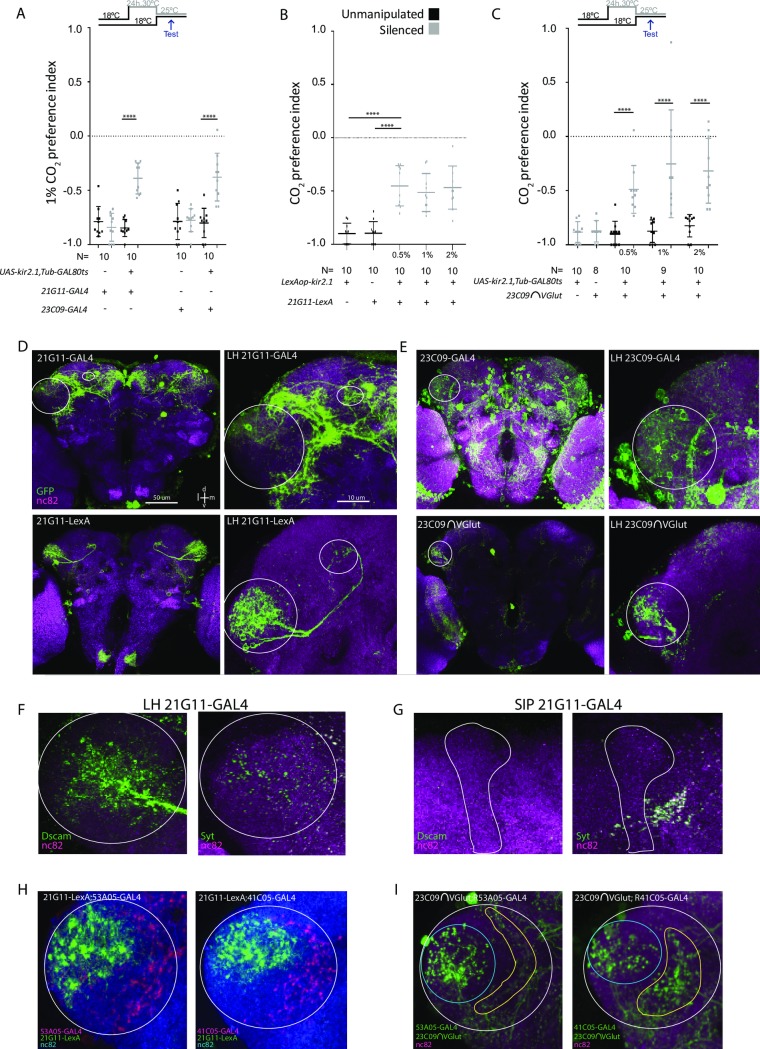
Activity in 21G11 and 23C09 neurons is required for behavioral response to CO2.(A) T-maze response to 1% CO2 of 21G11-GAL4 and 23C09-GAL4 flies driving UAS-Kir2.1, TubGAL80TS expression. (A and C) Black dots, no heat induction of Kir2.1 expression (see Materials and Methods). Gray dots, heat induction of Kir2.1 expression before test. The top and bottom lines represent the first and the third quartiles. The line across the box is the median. (B and C) T-maze response to three CO2 concentrations—0.5%, 1%, and 2%—of the flies with 21G11-LexA driving LexAopKir2.1 expression (B) and 23C09∩VGlut driving UAS-Kir2.1,TubGAL80TS expression (C). For 21G11-LexA driving LexAopkir2.1 expression, black dots represent parental controls, and gray dots represent constitutive Kir2.1 expression. For 23C09∩VGlut driving UAS-Kir2.1, TubGAL80TS expression, black dots represent no heat induction of Kir2.1 expression, and gray dots represent both parental controls and heat induction of Kir2.1 expression before test. Post hoc two-way ANOVA showed no significance when comparing among expressions for both control and test samples. (D) Brain and LH UAS-mCD8-GFP expression of 21G11-GAL4 and 21G11-LexA. (E) Brain and LH UAS-mCD8-GFP expression of 23C09-GAL4 and 23C09∩VGlut. (D–E) Circle highlights the LH, and oval highlights the SIP. (F and G) Dscam17.1-GFP and syt-HA expression in the LH and SIP of 21G11-GAL4 (green). In (F), circle highlights the LH. In (G), the vertical lobe of the MB is drawn to facilitate visualization of the adjacent SIP. (H) LH showing expression of 21G11-LexA (green) and the VPN lines 53A05-GAL4 (red) and 41C05-GAL4 (red). Circle highlights the LH. (I) LH expression of 23C09∩VGlut (blue circles) and the VPN lines 53A05-GAL4 (yellow line) and 41C05-GAL4 (yellow line). White circle highlights the LH. For all images, the brain neuropil was stained with nc82 (magenta and blue). ±SEM ****p < 0.0001. All p values are calculated with one-way ANOVA. d, dorsal; Dscam17.1, Down syndrome cell adhesion molecule with isoform 1 of the transmembrane domain; l, lateral; LH, lateral horn; m, medial; MB, mushroom body; nc82, monoclonal antibody to Bruchpilot; PN, projection neuron; SEM, standard error of the mean; SIP, superior intermediate protocerebrum; v, ventral; VPN, V-glomerulus–innervating PN.